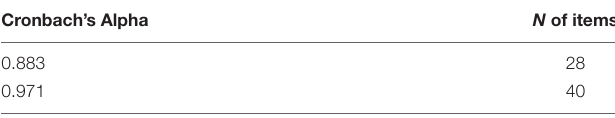
TABLE 1 | Reliability of the questionnaires.